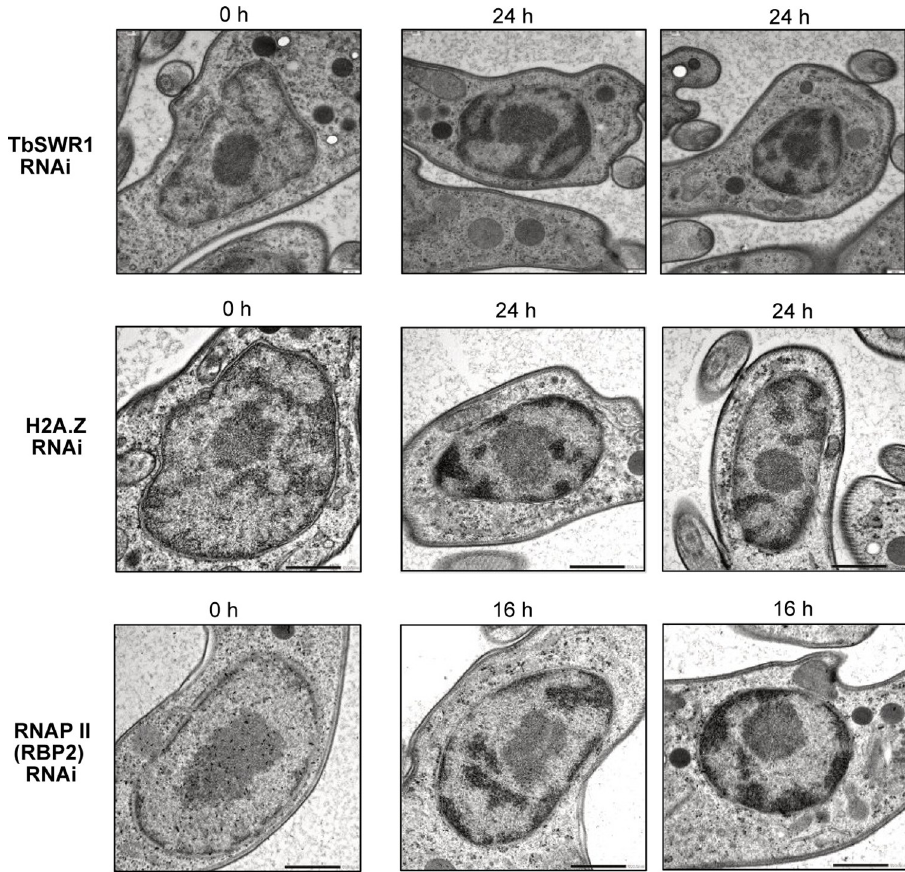
Fig 8. Loss of Tb SWR1 and RNAP II leads to chromatin condensation. Representative electron microscopy images of the nucleus of Tb SWR1-, H2A.Z- and RNAP II depleted and non-depleted parasites as indicated. Depletion of the proteins resulted in large black patches of condensed chromatin. Scale bar, 200 nm for Tb SWR1 RNAi and H2A.Z RNAi images, 500 nm for RNAP II (RBP2) RNAi images. Images of Tb SWR1 RNAi cells were obtained using a TEM (transmission electron microscope), images of RNAP II RNAi cells with a STEM (scanning transmission electron microscope).